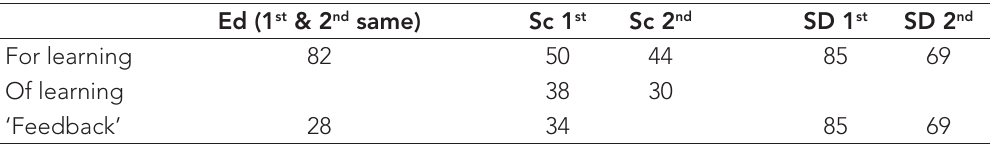
Table 2: Percentage rough definitions of FA provided that were classified as ‘for’ or ‘of’ learning, and including the word ‘feedback’ Ed (1 st & 2 nd same) Sc 1 st Sc 2 nd SD 1 st SD 2 nd For learning 82 50 44 85 69 Of learning 38 30 ‘Feedback’ 28 34 85